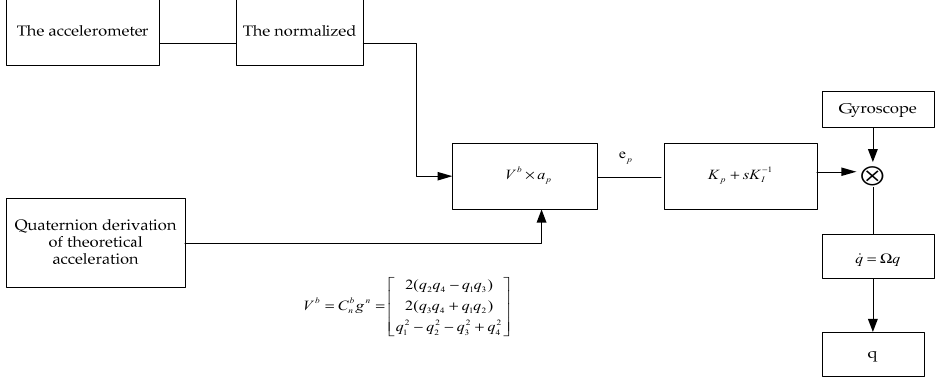
Figure 9. Mahony complementary filter schematic.